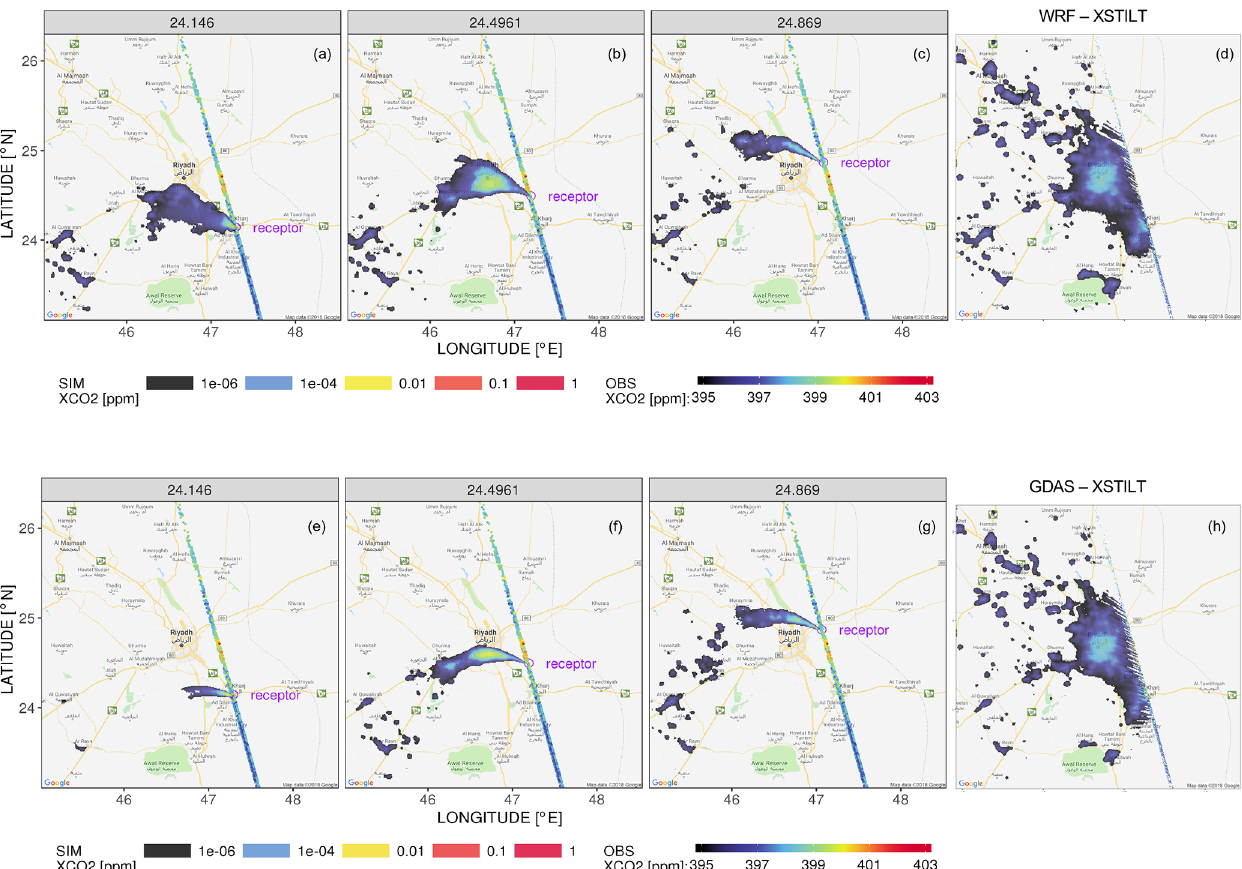
Figure 7. Spatial maps of 1km × 1km modeled XCO 2 contributions (ppm; log-scale) from three selected soundings along with screened observations (QF = 0) at 10:00UTC on 29 December 2014 over Riyadh, with meteorological fields driven by WRF (a–d) and GDAS (e– h) . Panel (d) and (h) denote the latitude-integrated XCO 2 . ff contributions (with weights of receptor spacings, e.g., 0.02 ◦ ) using WRF and GDAS, derived from spatial XCO 2 enhancements for over 60 column receptors along each overpass. The sum of the latitude-weighted spatial XCO 2 enhancements over all grid cells (in panel d or h ) equals to the latitude-integrated XCO 2 . ff signal (ppm-degree of latitude) reported in Sect. 3.5. Only large enhancements > 10 − 6 ppm are